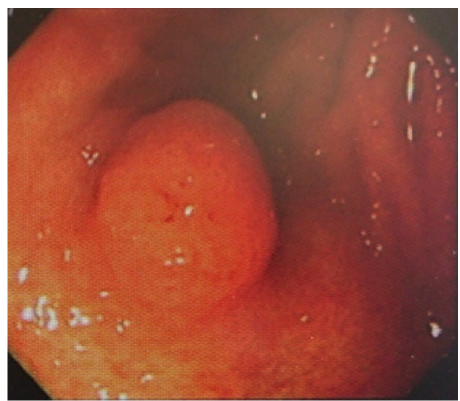
Figure 3. A 1 cm mass was newly found in the patient’s stomach through esophagogastroduodenoscopy. Biopsy of the mass histologically revealed a high-grade (group 4) gastric adenoma, which was also suspected as gastric cancer.